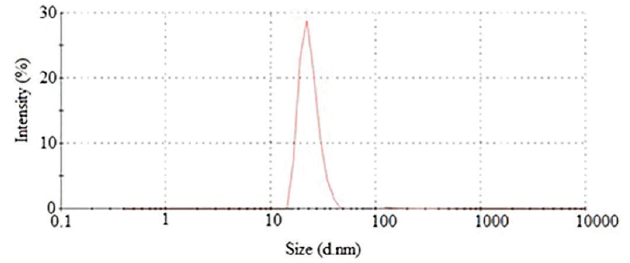
FIGURE 5 - Particle size distribution of LF3 formulation at 24 h post dilution with distilled water using Malvern Zetasizer.